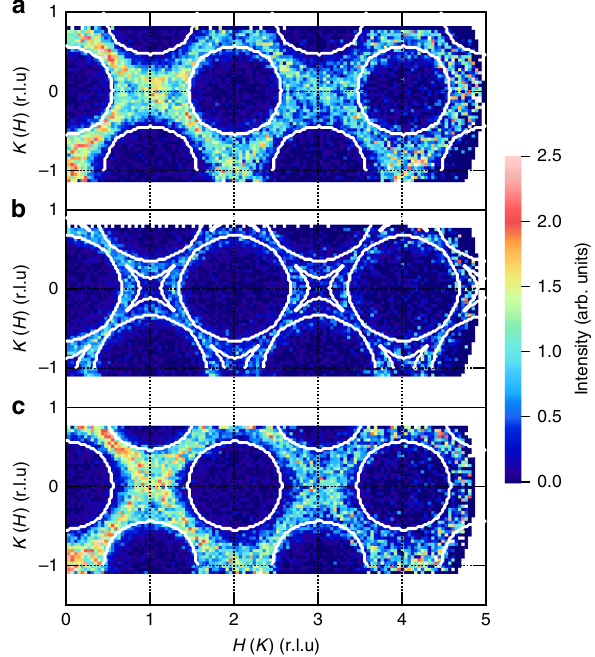
Fig. 4 Scattering intensities sliced with the constant energy. Intensity is given at a 2.48, b 2.60, and c 2.72 meV for each ( H , K ) or ( K , H ) position after integrated for Δ E = ±0.06 meV and all measured L values. The common color scale is used. White solid curves indicate boundaries between zero and nonzero intensity regions expected from the dispersion relation. Source data are provided as a Source Data fi le the structure factor becomes very close to that represented in Fig. 2d. Thus, the intensities of the low-energy and high-energy bands greatly vary around a crossing point of 0.74 r.l.u., indicated by arrows in Fig. 2d, e; the intensities of the high-energy band signi fi cantly increases above the crossing point, while those of the low-energy band become undetectable. Even at different H and K , the band crossing occurs at the same energy, J , since the two dimers are symmetrically equivalent. Consequently, the wavevector-independent gap centered at J appears between two triplon bands. Note that the alternation is only allowed along the a -axis owing to the symmetry. Therefore, the observed triplon bands can be labeled to be along H or K , as denoted in Fig. 2a – c.